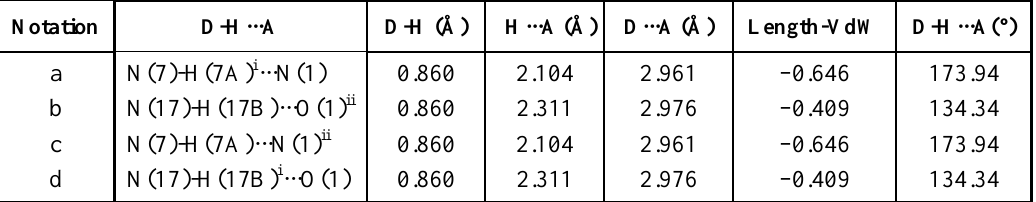
Table 1. Hydrogen bond geometry in compound